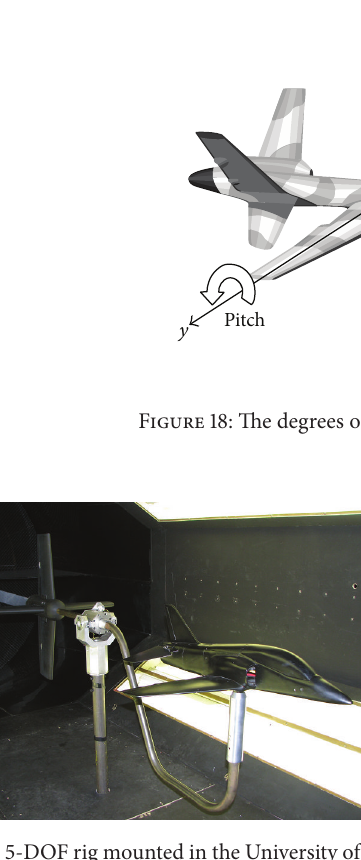
Figure 19: The 5-DOF rig mounted in the University of Bristol’s 7 × 5 ft closed-section wind tunnel